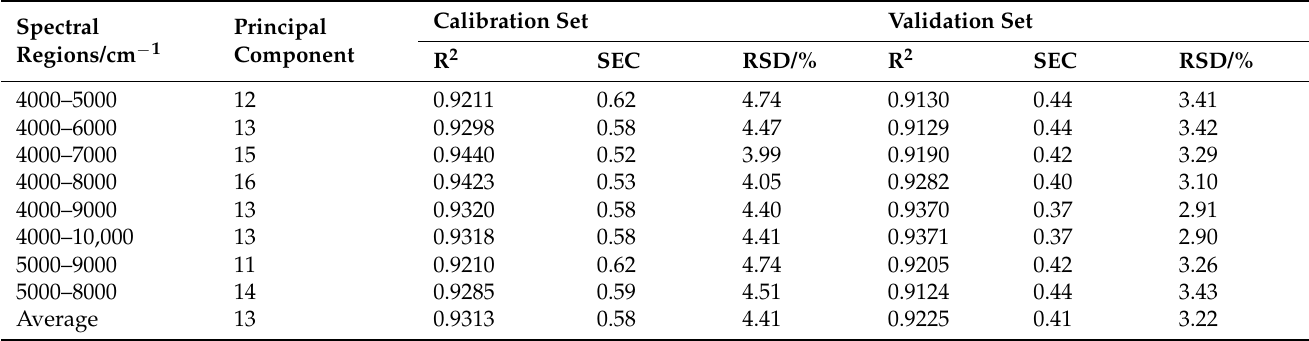
Table 2. Influence of spectral range on NIR prediction results